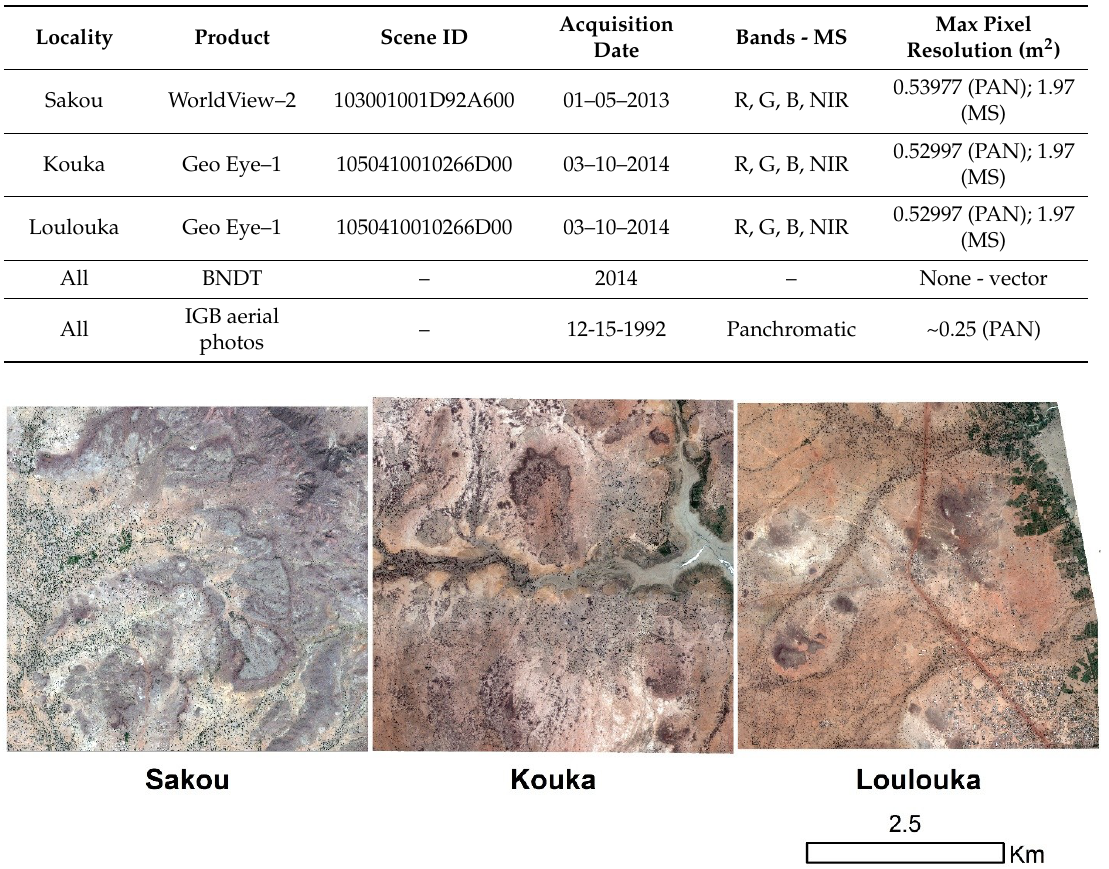
Table 1. Data used.